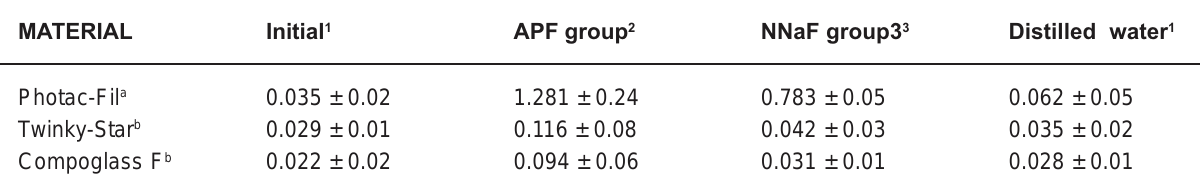
There was no statistically difference among groups with the same superscript numbers and materials with the same superscript letters (p>0.05). SD= standard